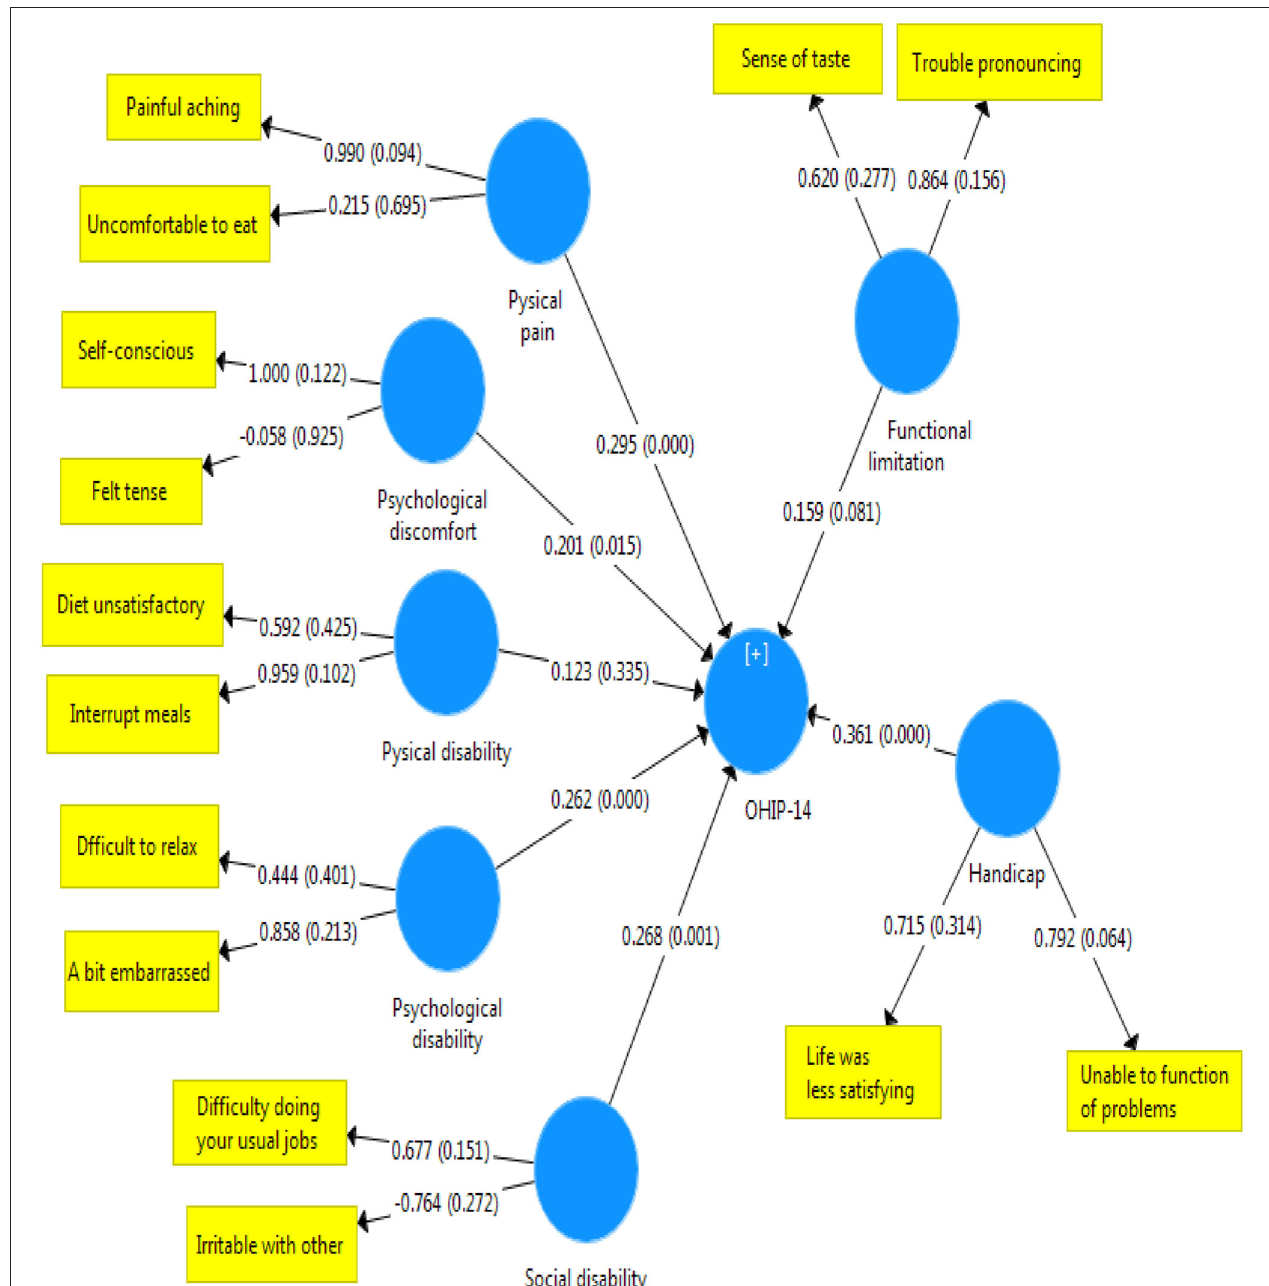
FIGURE 1 | Status and severity of the relationship between the scores in the dimensions of OHIP-14 scale and the total score of quality of life related to oral health in stimulant